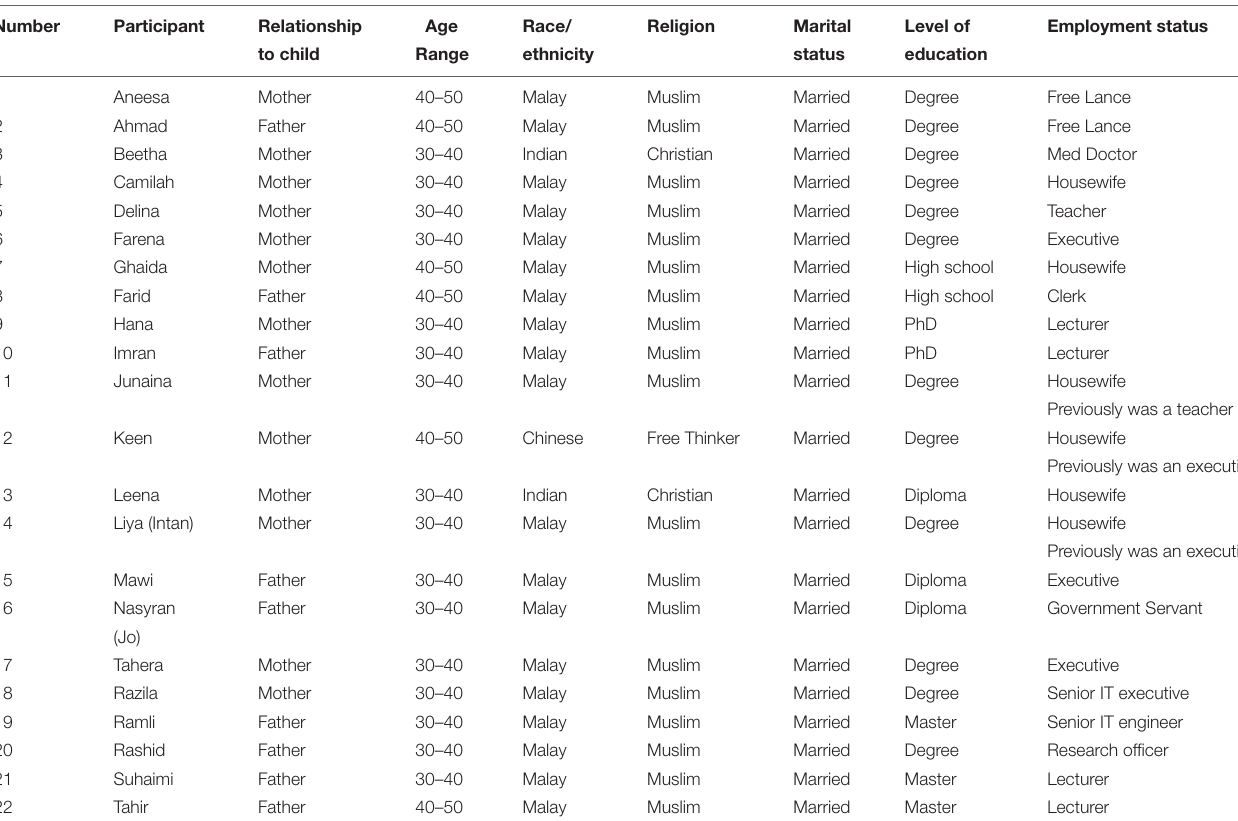
TABLE 1 | Demographics of mothers and fathers of children with